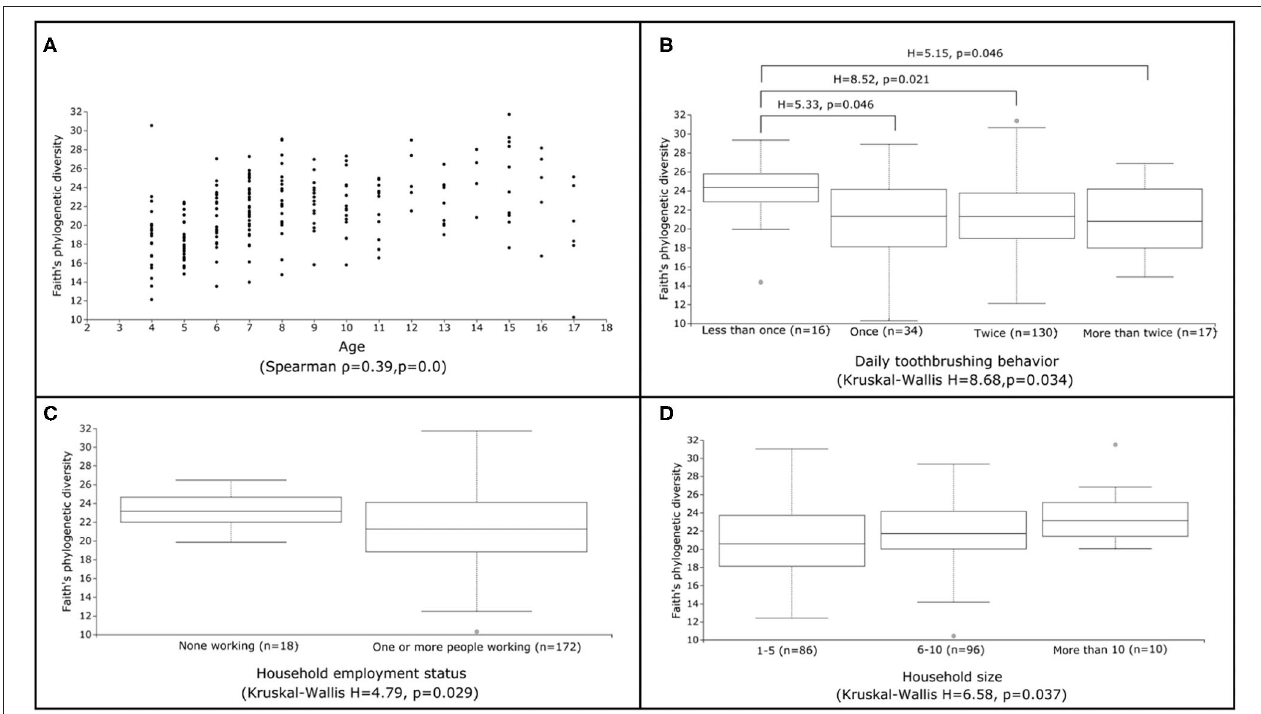
FIGURE 2 | Factors linked to significant differences in alpha diversity. Scatter (A) and box (B-D) plots illustrating the range of Faith’s phylogenetic diversity values for selected metadata categories identified as significantly linked to alpha diversity ( A : age, B : daily toothbrushing behavior, C : household employment status, D : household size). Results of overall Spearman correlation (continuous variables) and Kruskal-Wallis (categorical variables) tests are also displayed, along with any statistically significant (FDR p < 0.05) pairwise Kruskal-Wallis test comparisons between groups. All other pairwise Kruskal-Wallis test comparisons were not statistically significant.